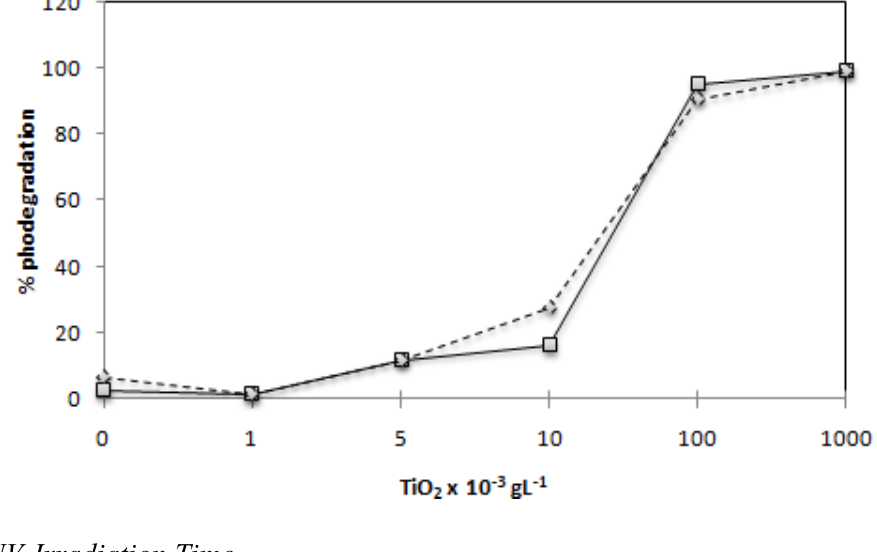
Figure 1. Effect of TiO amount on the complete degradation of 30 mg·L − 1 .I. Reactive Red 2 239( ) and C.I Reactive Black 5 (------) dyes in 120 min of irradiation with 2,60 mW/cm 2 of irradiation power by a 125 W mercury